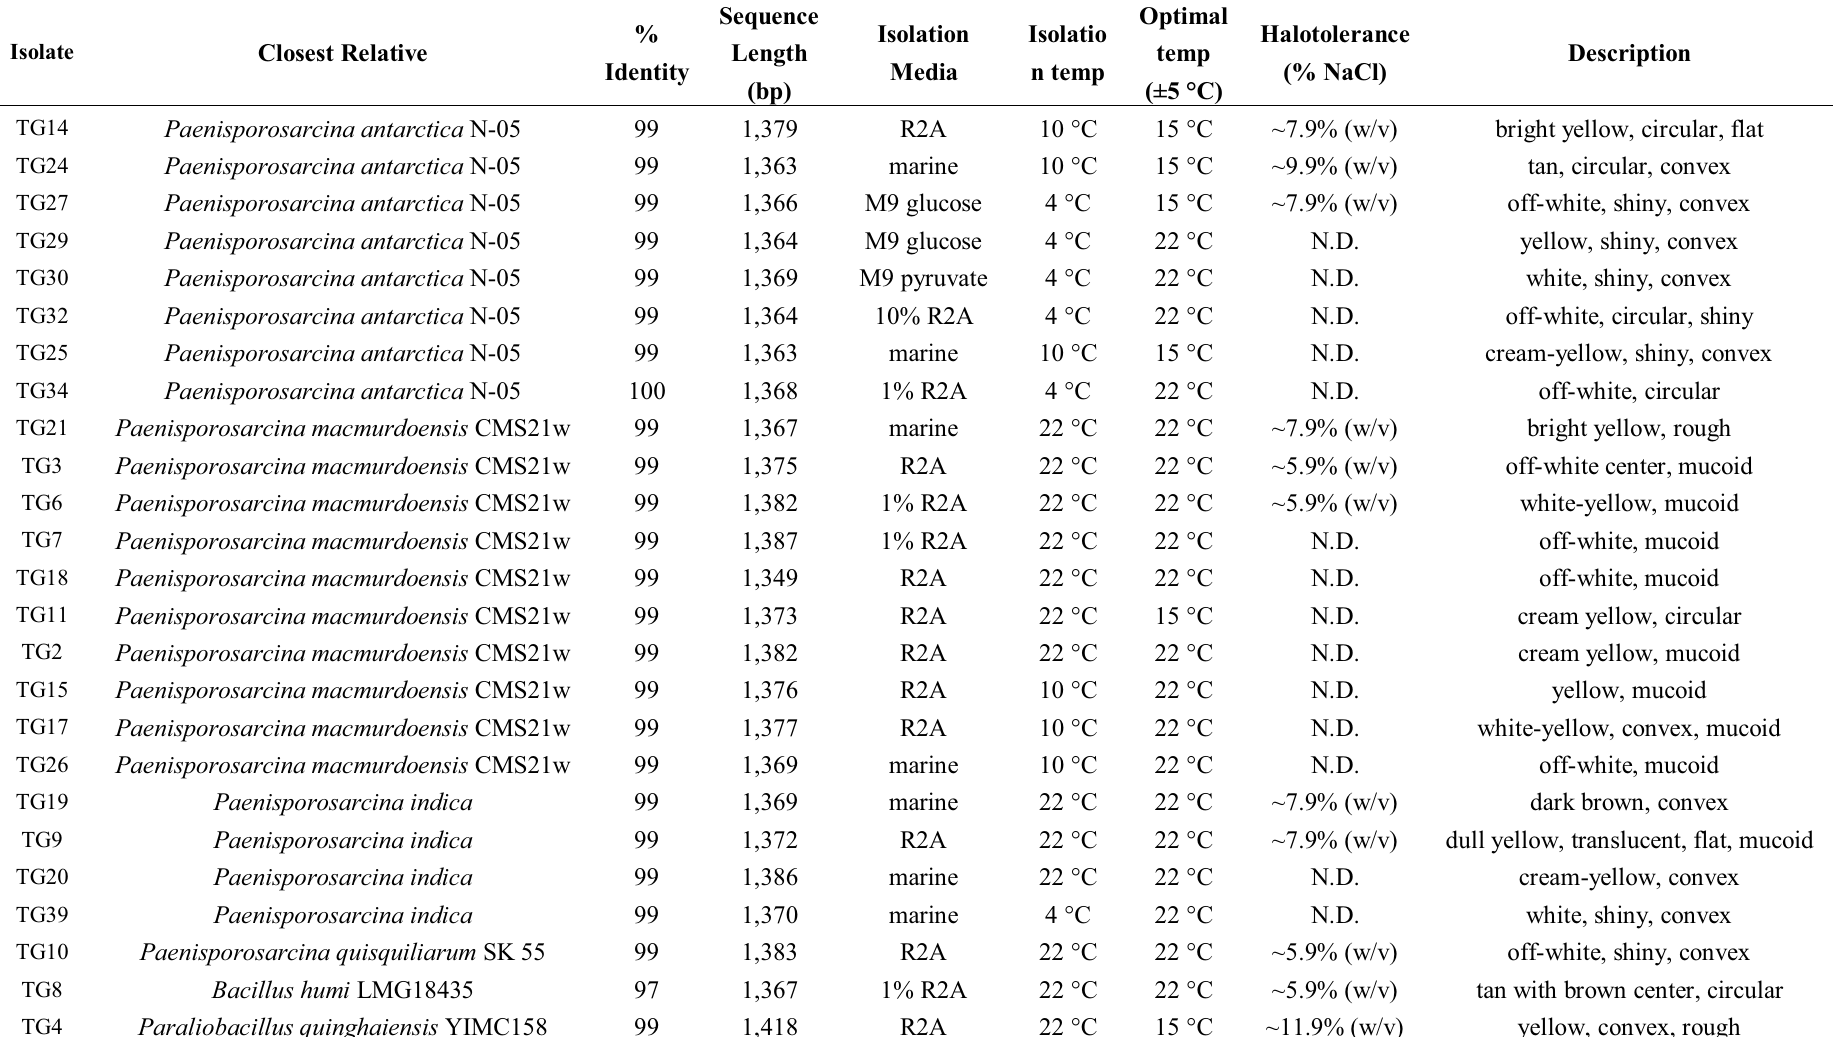
Table 1. Phenotypic description of basal ice isolates and their phylogenetic relationships to cultured bacteria. N.D. = not determined. Isolate